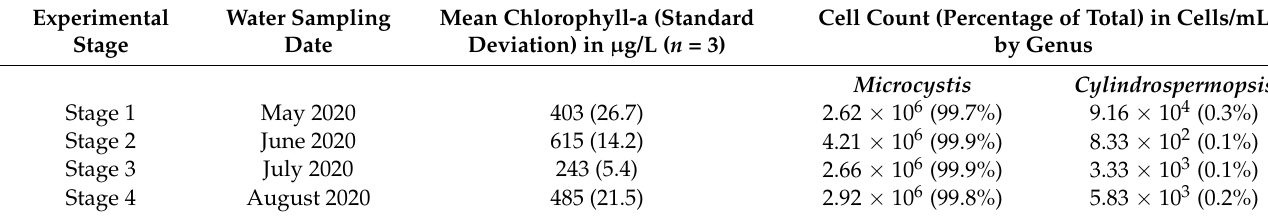
Table 1. Initial chlorophyll-a concentrations and cell counts for four experimental stages.